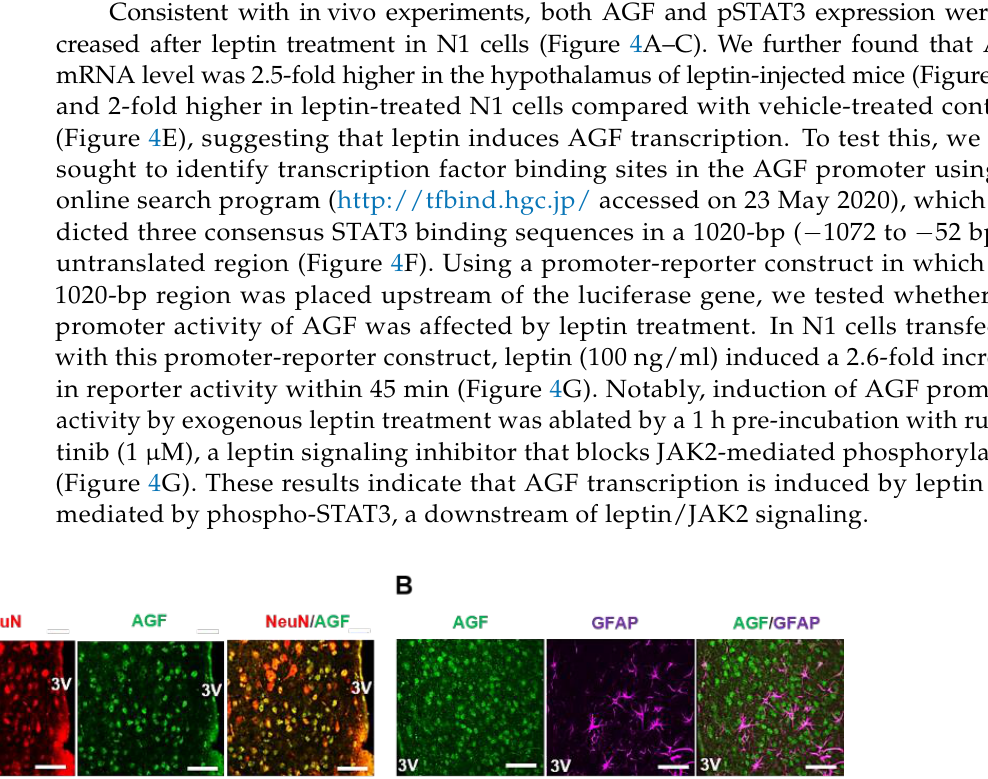
Figure 2. AGF is colocalized to proopiomelanocortin (POMC) neurons rather than glial fibrillary acidic protein (GFAP)-positive cells in the hypothalamus. ( A , B ) Immunofluorescence staining of AGF (green) and NeuN (red), a neuronal nuclei marker and GFAP (magenta), an astrocyte marker in the hypothalamus section. ( C ) POMC neurons in the hypothalamus, detected based on red fluorescence in POMC-specific tandem dimer Tomato (tdTomato) expressing reporter mice, and AGF immunofluorescence staining. Brain slices were prepared by cryosectioning (25 µ m/section). Sections were incubated overnight at 4 ◦ C with Alexa 488-conjugated mouse anti-AGF antibody (1:100). Fluorescence was visualized by confocal microscopy. A yellow-colored neuron represents the colocalization of AGF with POMC. ( D ) Number of AGF and POMC double-positive neurons in the ARC (between − 1.7 and − 3.4 mm from bregma) presented as means ± SD ( n = 10/slide). Scale bars: 50 µ m